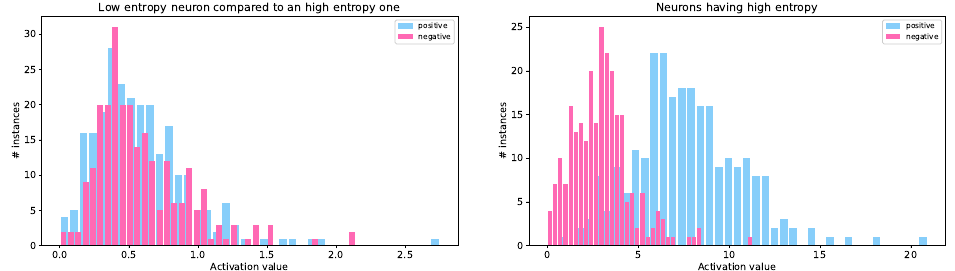
Figure 5. Activations of two high-entropy reference neurons, one compared against a low-entropy neuron ( left ) and one against a high-entropy neuron ( right ), both in the role of N cf . Colors of bars correspond to the classes M 0 and M 1 defined by the reference neuron N ref .